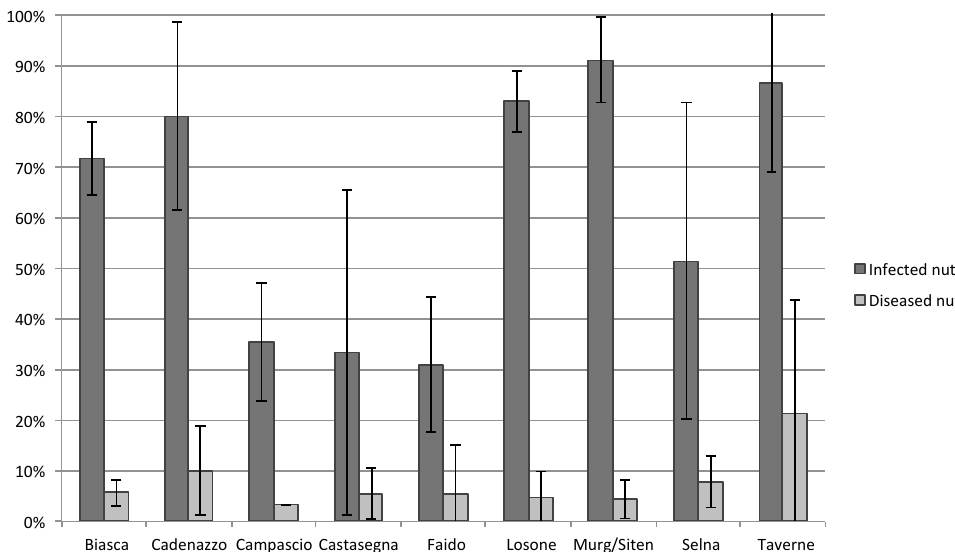
Figure 2. Average percentage of infected nuts (from which Gnomoniopsis castanea was isolated) and diseased nuts (showing G. castanea rot symptoms) of the three sampled trees in each sampling location. Black bars represent standard errors. For lo- calities Biasca and Cadenazzo, standard error between batches is shown (see Table 5 in Supplementary Material for percent- age of infected nuts from each tree). Capital letters represent significant differences of proportions of infected nuts between localities (ANOVA, P < 0.05). No significant differences between numbers of diseased nuts were found between